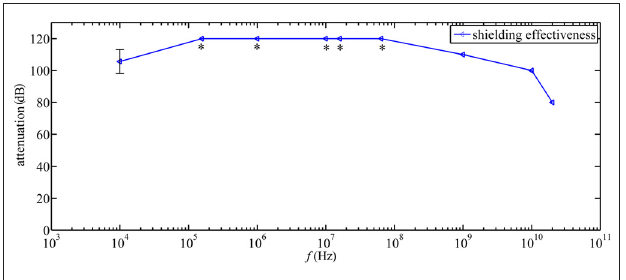
FIGURE 2 | Shielding effectiveness measurements in experimental chambers at different frequencies in accordance to the IEEE-299 standard (IEEE, 1997) . ∗ indicates that the shielding effectiveness was higher than the largest measurable value of 120 dB.